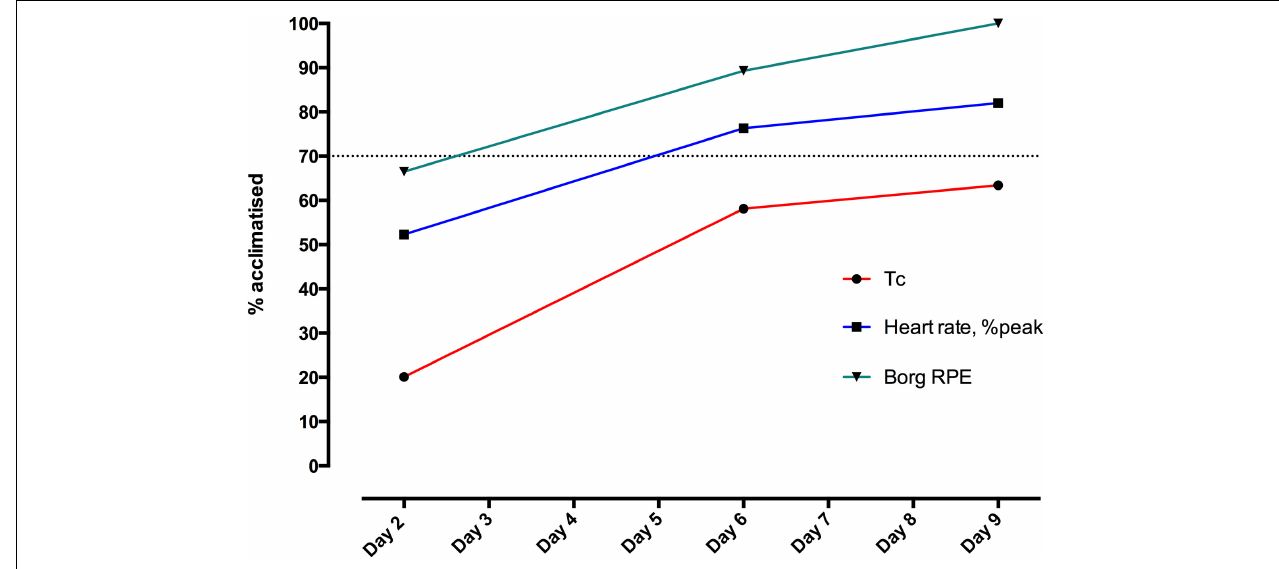
FIGURE 1 | Heat adaptation in 21 volunteers, displayed as progress toward full (100%) acclimatization status on Day 23 in Cyprus, relative to pre-deployment baseline in United Kingdom (0% acclimatized). Volunteers performed the acclimatization protocol described in Table 1 , with 60 min stepping at 50% VO 2 max in a climatic chamber controlled to WBGT 34 ◦ C, at United Kingdom baseline and on Days 2, 6, 9, and 23 following arrival in Cyprus (substituted for usual acclimatization exercise on these days). Acclimatization status (%) was calculated by parameter, in terms of the end-exercise value relative to that on Day-23. Tc, core body temperature; Borg RPE (Borg, 1973), Relative Perceived Exertion according to Borg’s scale (may need to reference: as below). Dotted line indicates 70% adaption.